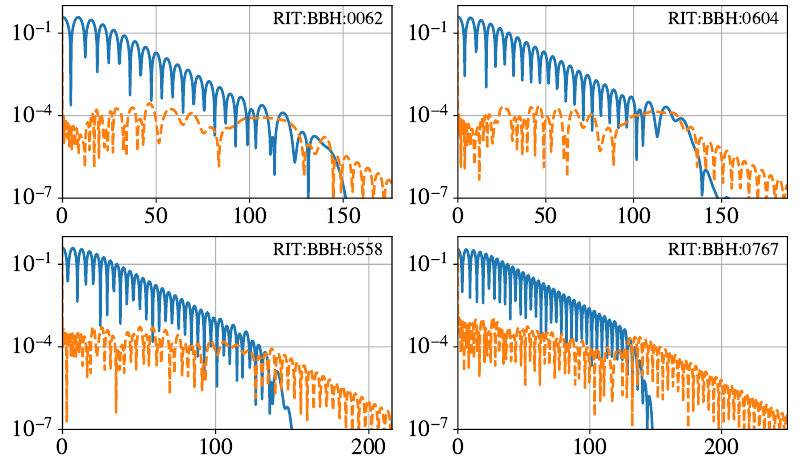
Figure A2. Real part of the ( (cid:96) = 2, m = 2 ) spheroidal harmonic mode (cid:60) ( ˜ h 22 ) of RIT NR waveforms listed in Table A1 and their QNM fit